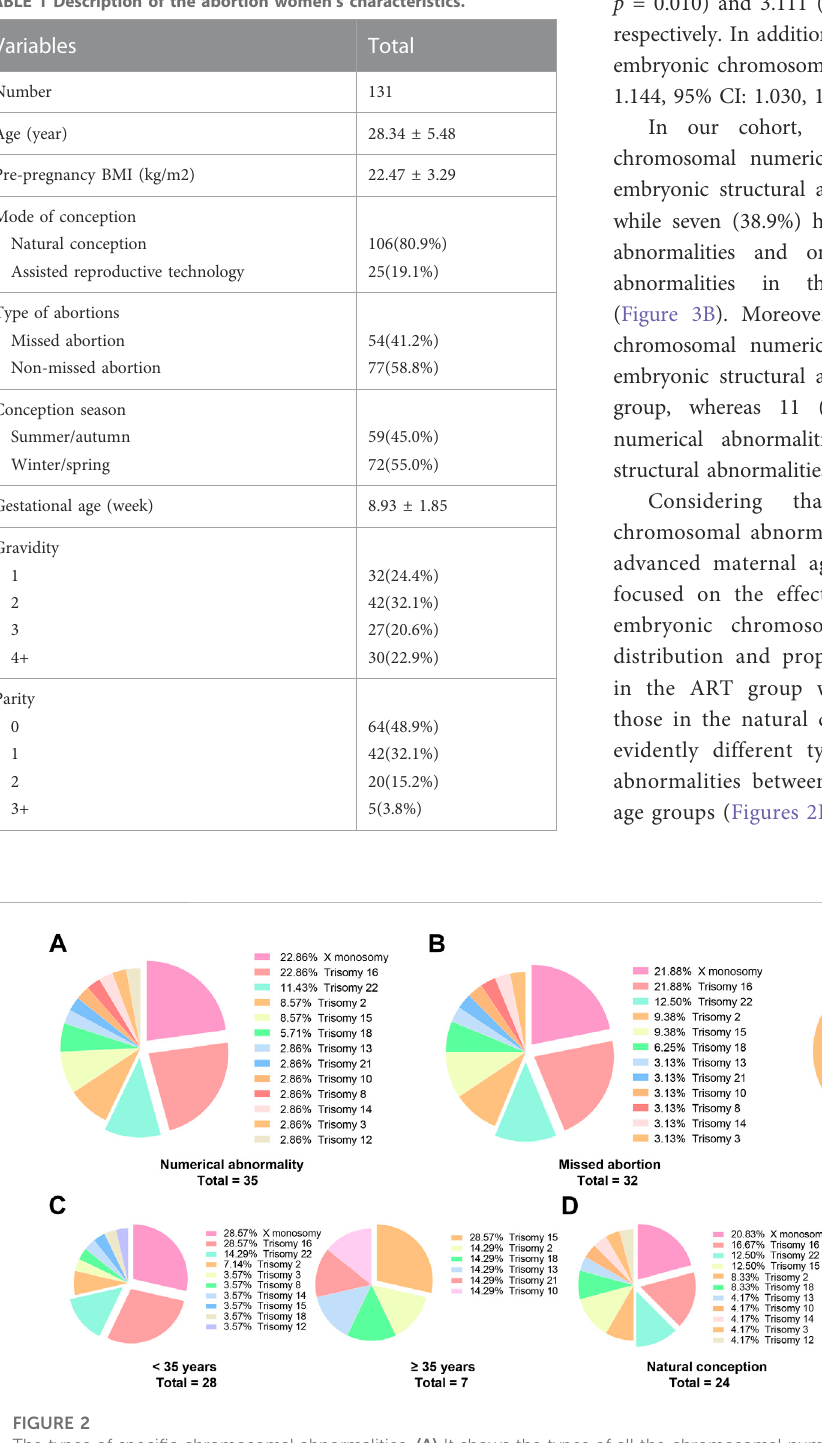
FIGURE 2 The types of speci fi c chromosomal abnormalities. (A) It shows the types of all the chromosomal numerical abnormalities of the aborted embryos; (B – D) According to missed abortion, maternal age and ART, the types of chromosome abnormalities were